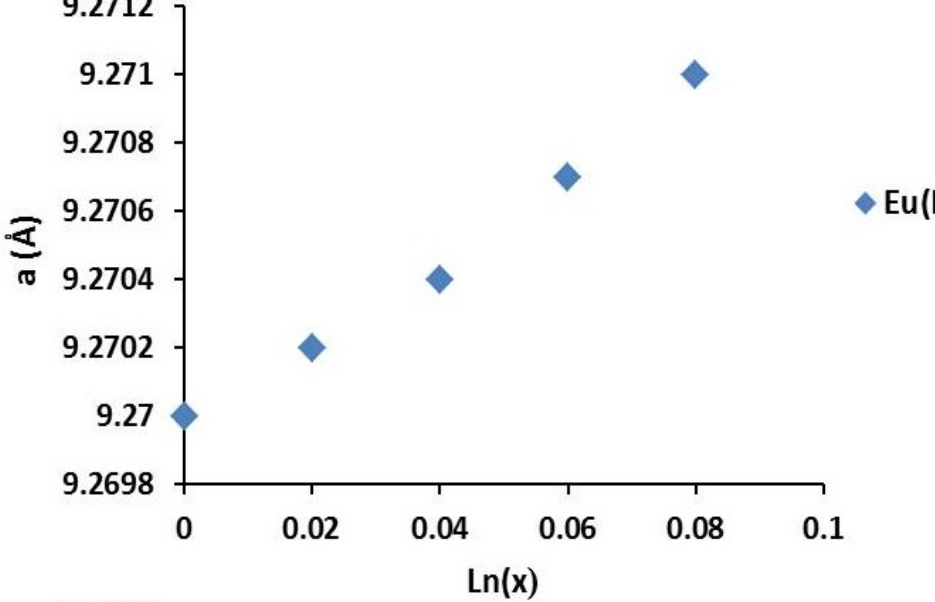
Figure 2. The lattice constant of Eu x Y 2-x O 3 (x = 0 to 0.08) dependent upon Eu 3+ doping on Y 3+